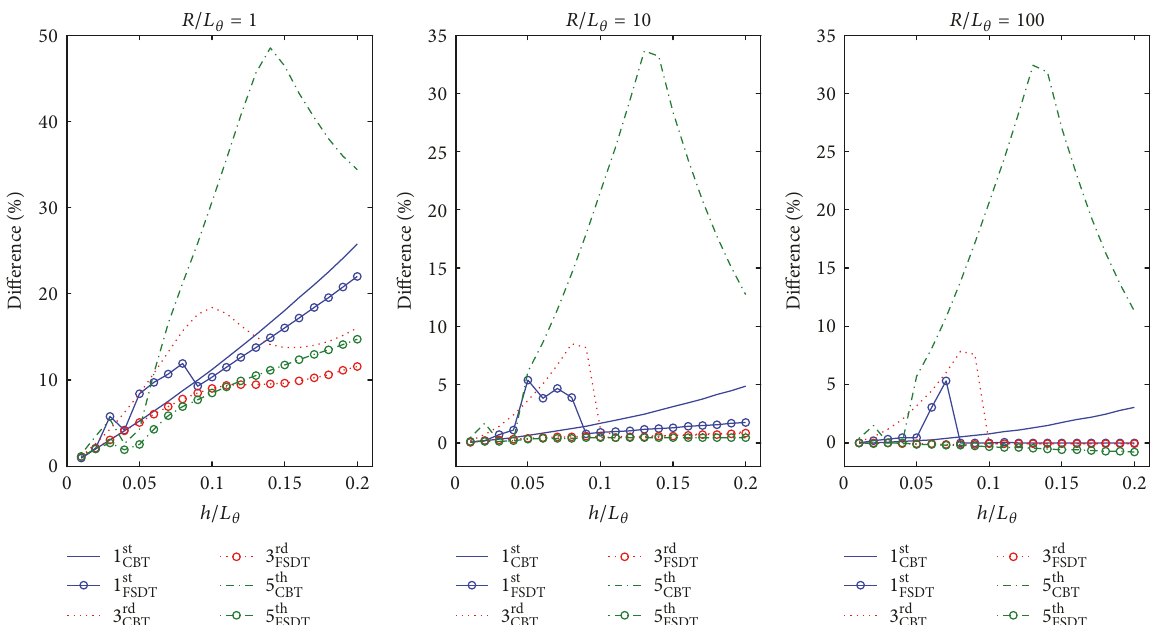
Figure 3: Relative deviations between frequency parameters Ω based on the CBT/FSDT theory models to those of 2D theory for circular beams with various thickness ratios (F-C boundary